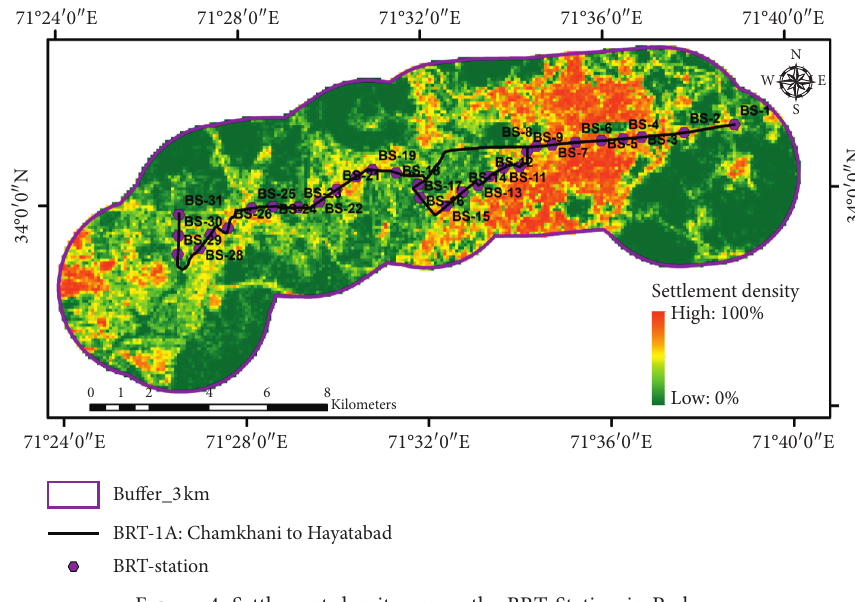
Figure 4: Settlement density across the BRT Station in Peshawar.